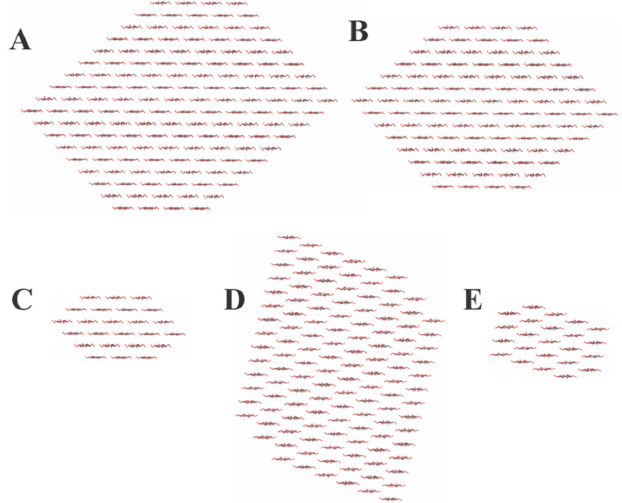
Figure 3. Models of the cotton cellulose and nanocellulose transducer materials based on the X-ray diffraction patterns. ( A ) CFP; ( B ) CNC; and ( C – E ) cellulose I, cellulose II, and amorphous contributions to the diffraction pattern for NA.